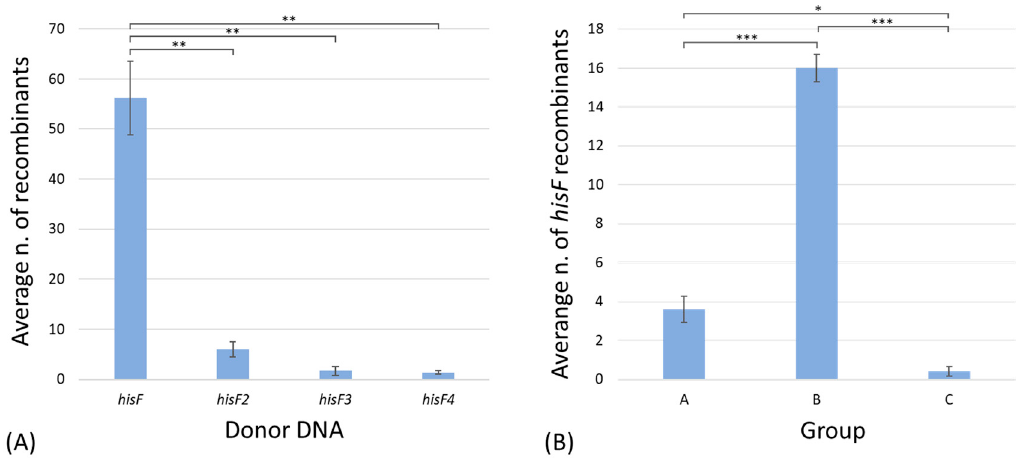
Figure 4. ( A ) Average numbers of His + colonies obtained from the 5 experiments, divided on the basis of the length of the hisF fragment used for the transformation. ( B ) Average numbers of His + colonies obtained from the transformation with the hisF gene across the 5 experiments, divided on the basis of the different groups. Bars represent standard errors. Significant differences were evaluated through analysis of variance (ANOVA) performed using Tukey’s pairwise test. Asterisks indicate significant differences (*: p -value < 0.01; **: p -value < 0.001; ***: p -value < 0.0001). The average number of transformant colonies was calculated for every experiment.